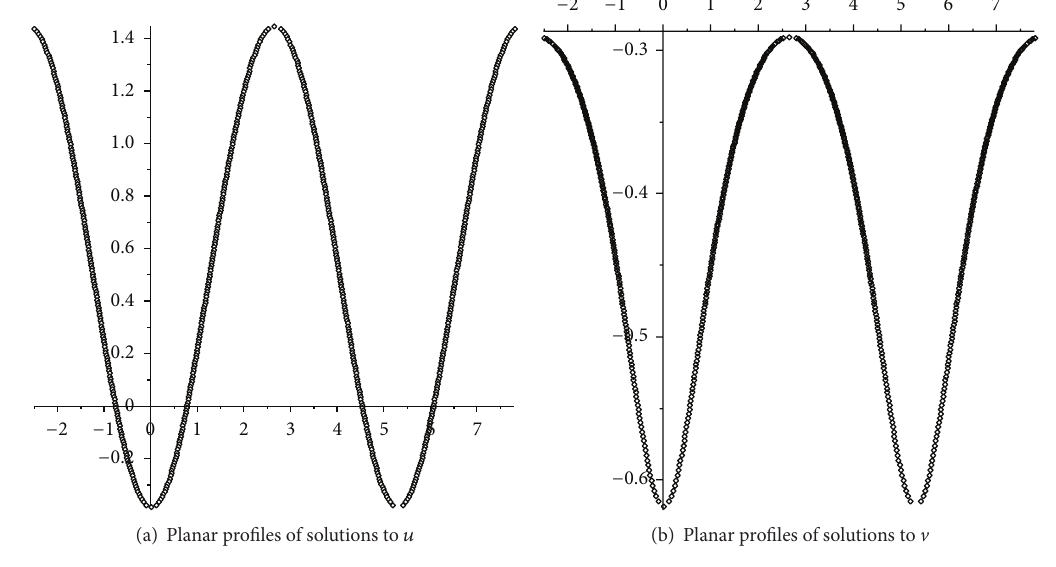
Figure 5: Smooth periodic wave solutions.